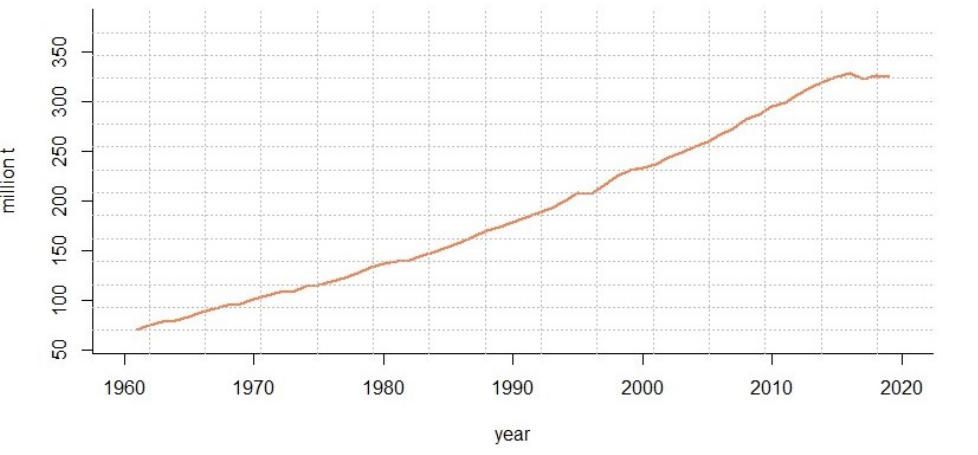
Figure 1. Global meat production from 1961–2019